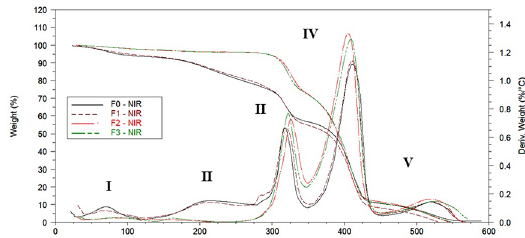
Figure 3. TGA/DTG curves of NIR blends